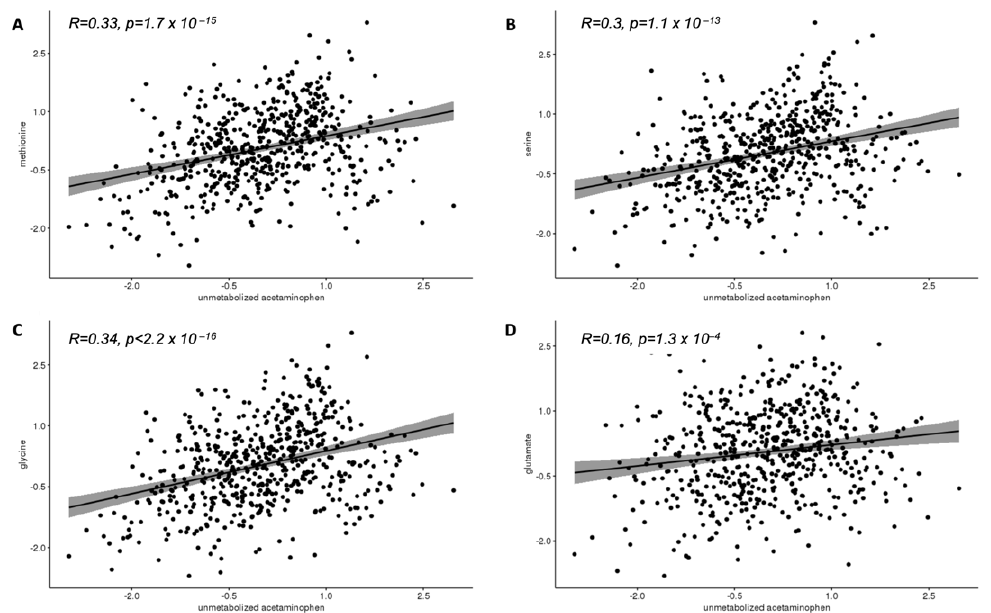
Figure 2. Associations of cord plasma unmetabolized acetaminophen a with cord plasma methionine ( A ), serine ( B ), glycine ( C ), and glutamate ( D ) a . a Inverse normal transformed intensities.